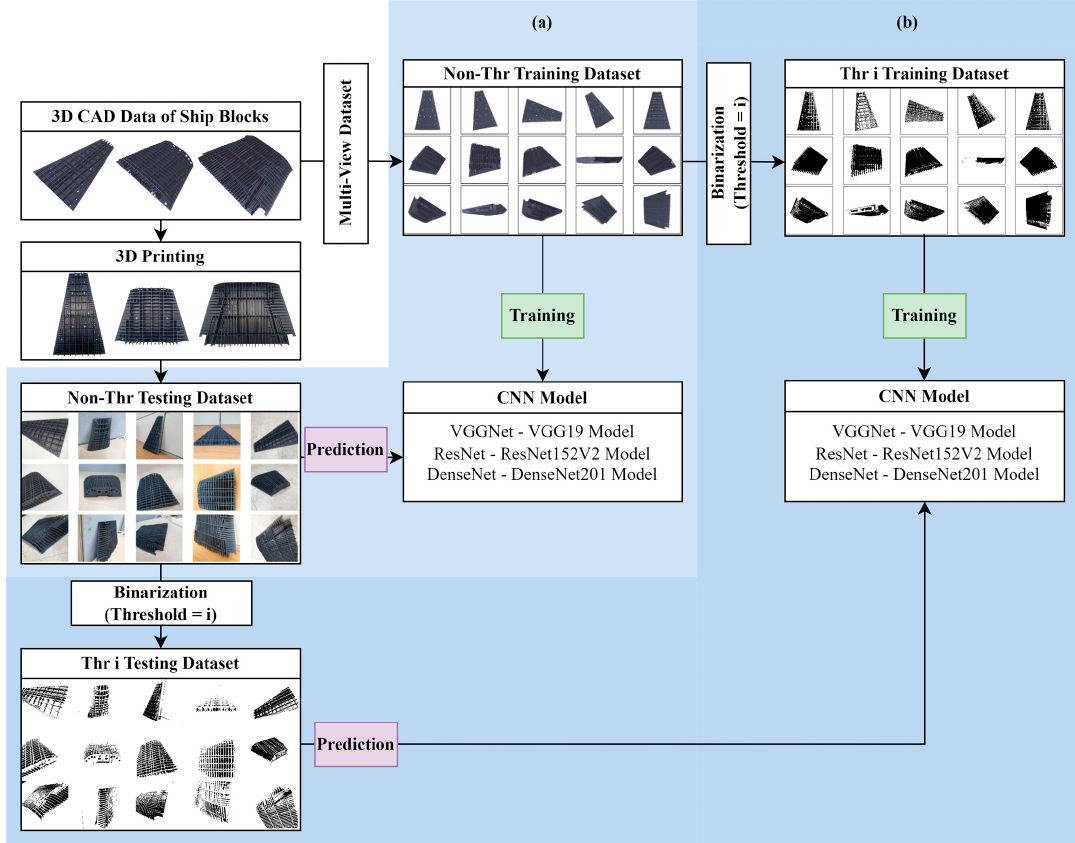
Figure 1. Process diagram for ‘Identification of Ship Hull Blocks using Convolutional Neural Network with Multi-View Image set of 3D CAD Data’: ( a ) Experimental environment of Non-Thr dataset; ( b ) Experimental environment of Thr dataset.